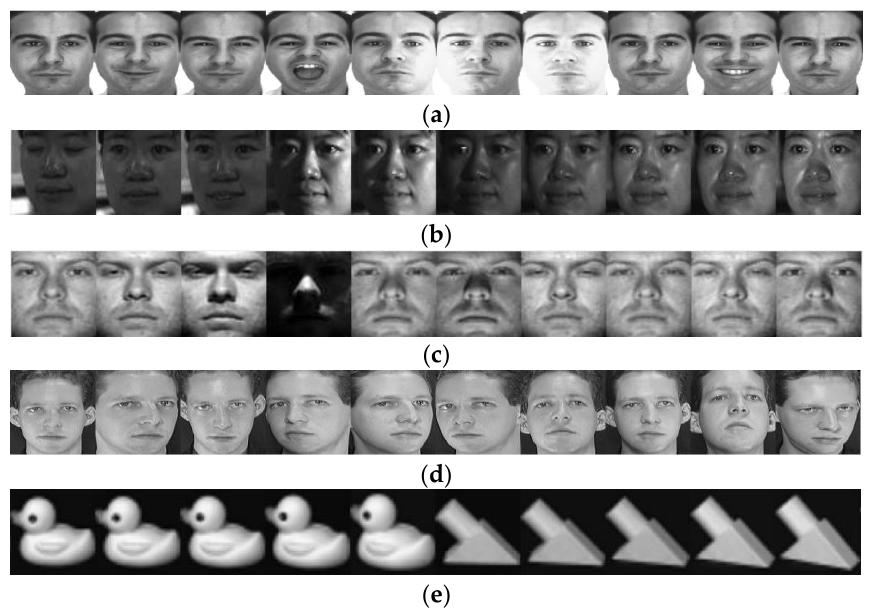
Figure 3. Selected images from the five databases: ( a ) AR; ( b ) CMU PIE; ( c ) Extended YaleB; ( d ) ORL; ( e ) COIL20.